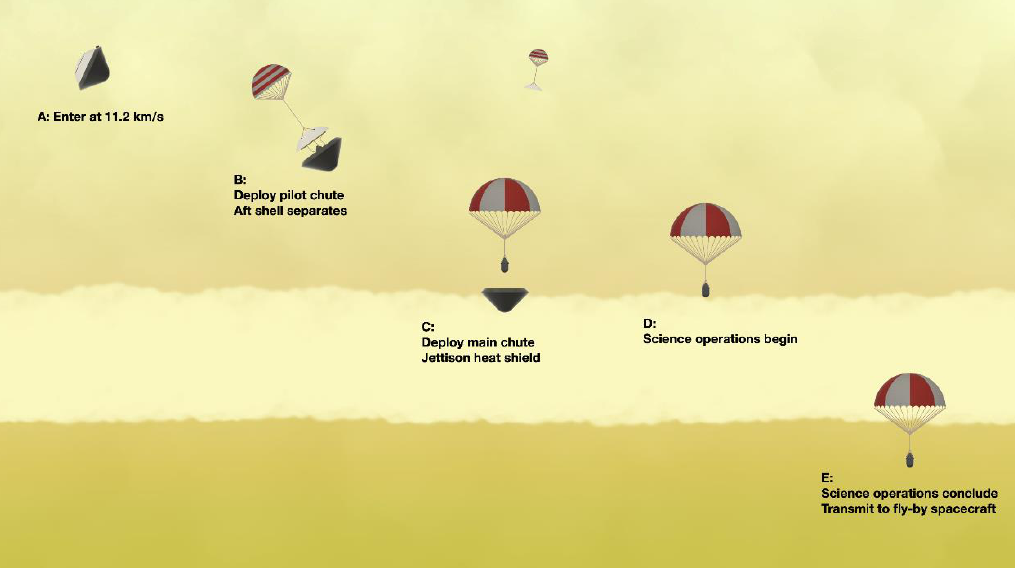
Figure 3. Representative concept of operations for the VLF Habitability parachute probe Habitability Mission.